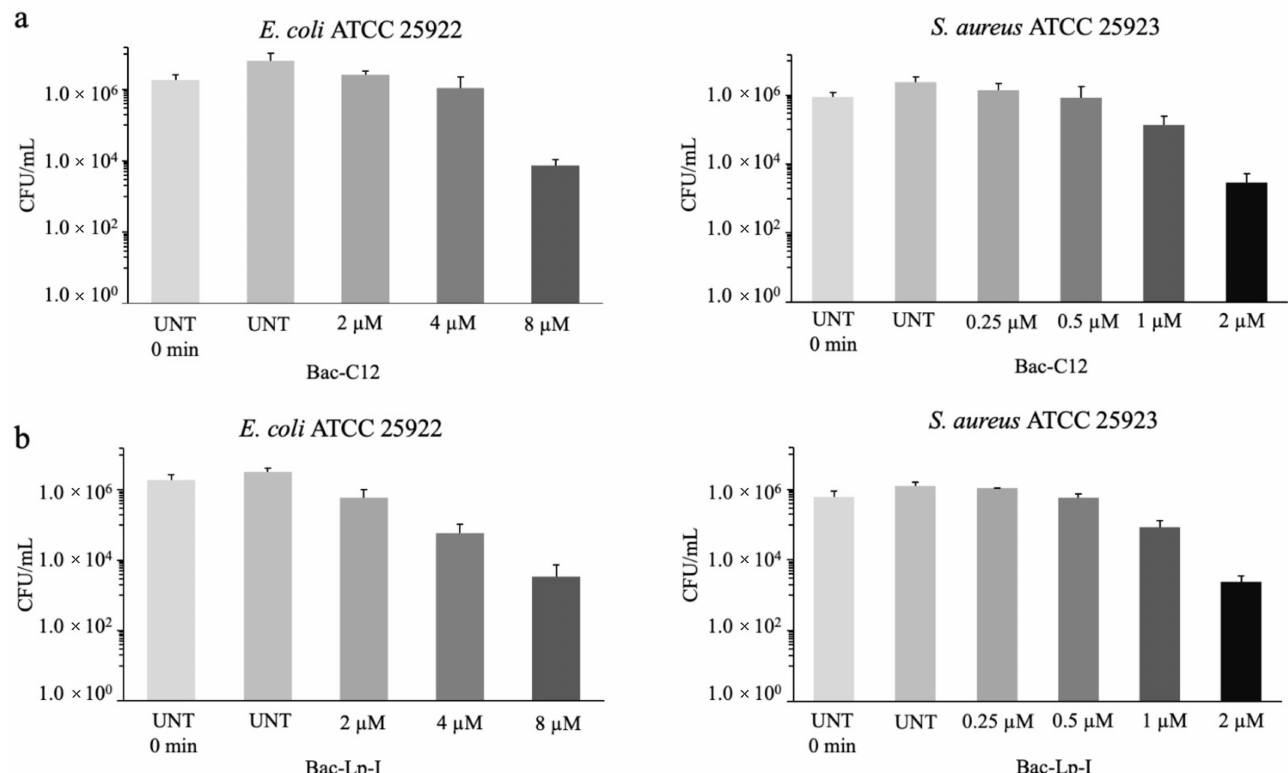
Figure 2. Evaluation of the bactericidal activity of Bac-C12 and Bac-Lp-I on E. coli ATCC 25922 and S. aureus ATCC 25923. The bactericidal activity with Bac-C12 (panel a ) and Bac-Lp-I (panel b ) on E. coli ATCC 25922 and S. aureus ATCC 25923 cells was determined using a mid-logarithmic phase bacterial suspension, diluted in fresh MHB to a final concentration of 10 6 CFU/mL, and incubated for 30 min at 37 ◦ C with increasing concentrations of peptide. Samples were then diluted in PBS, plated on MH agar, and incubated overnight to allow the colony counts. UNT = untreated cells. Data are the mean ± SD of three independent